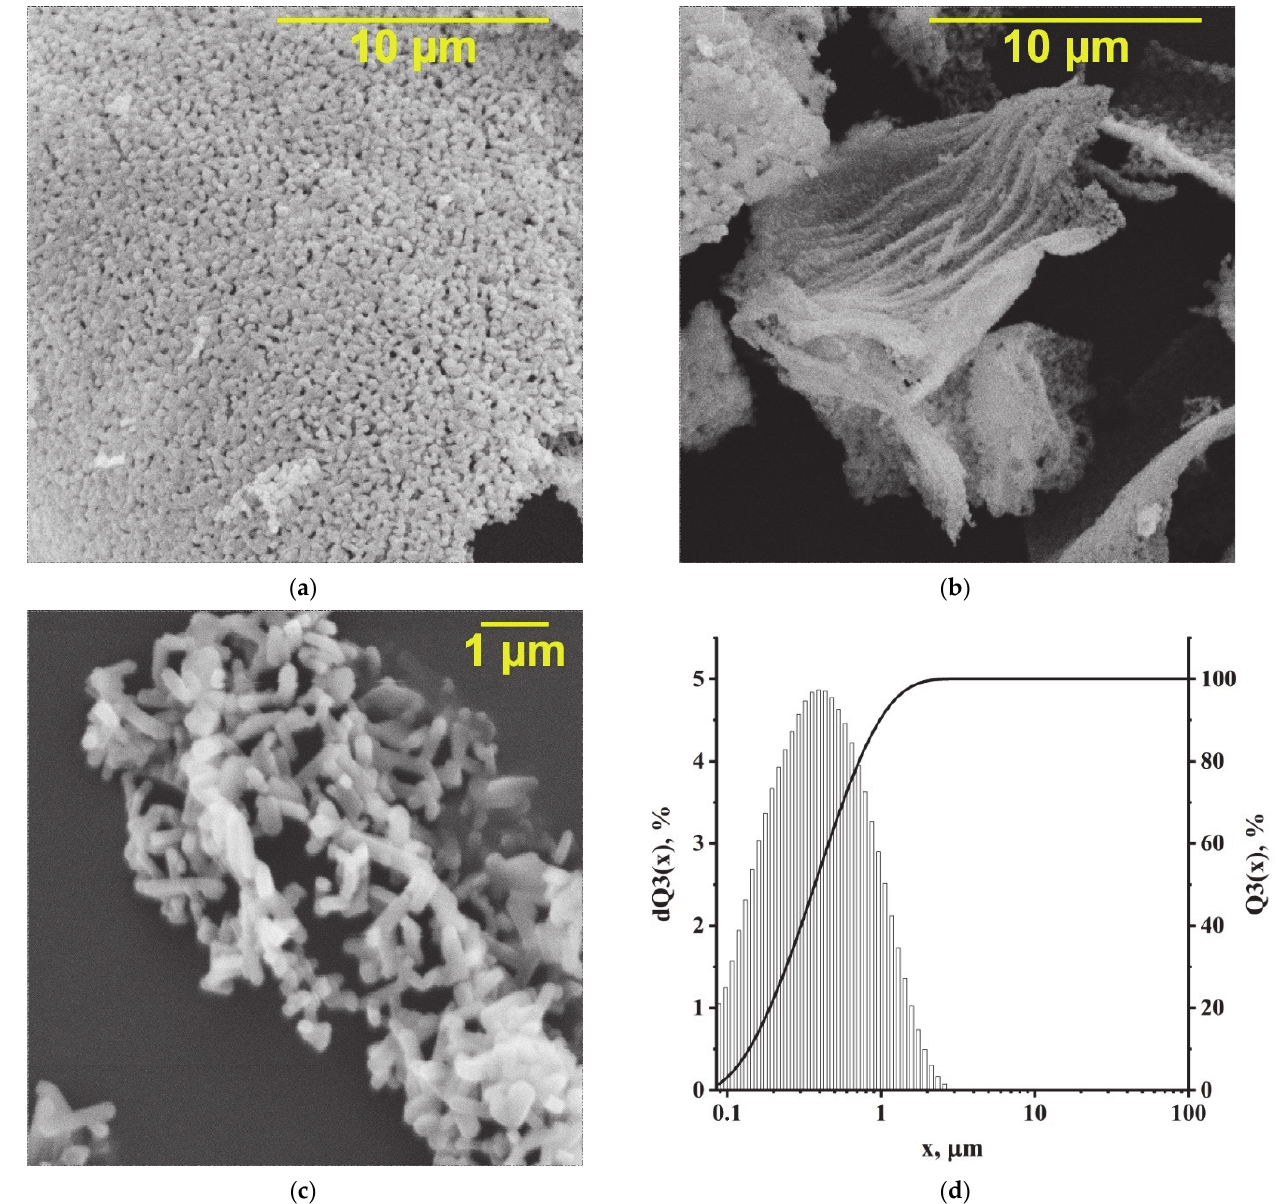
Figure 3. SEM microphotographs ( a – c ) and particle size distributions ( d ) of KFTO(H) nanopowder (x is particle size, μ m; dQ3(x) is the differential percentage of particle volume entering the range between the minimum and maximum size; Q3(x) is the integral percentage of the particle volume relevant to the range in question, showing which fraction of the particle volume is below the specified size).